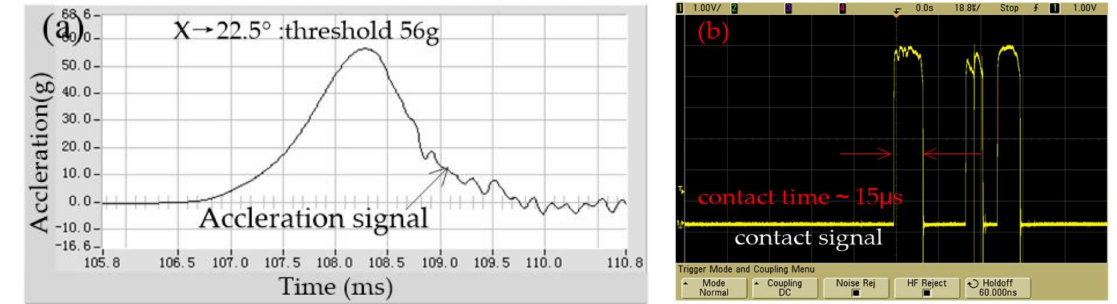
Figure 10. The tested threshold in 22.5 degrees away from the x-axis.